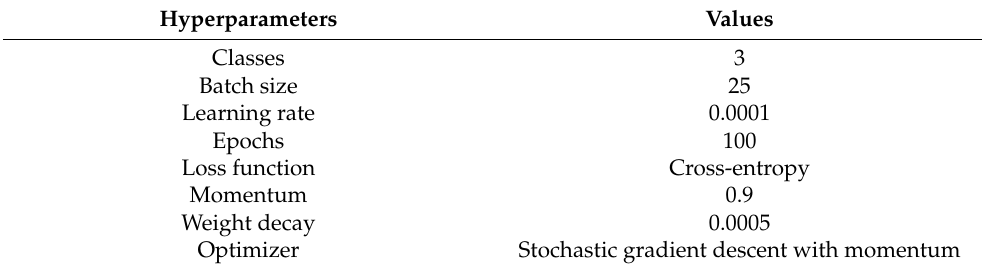
Table 3. The hyperparameters in the multimodal data fusion CNN